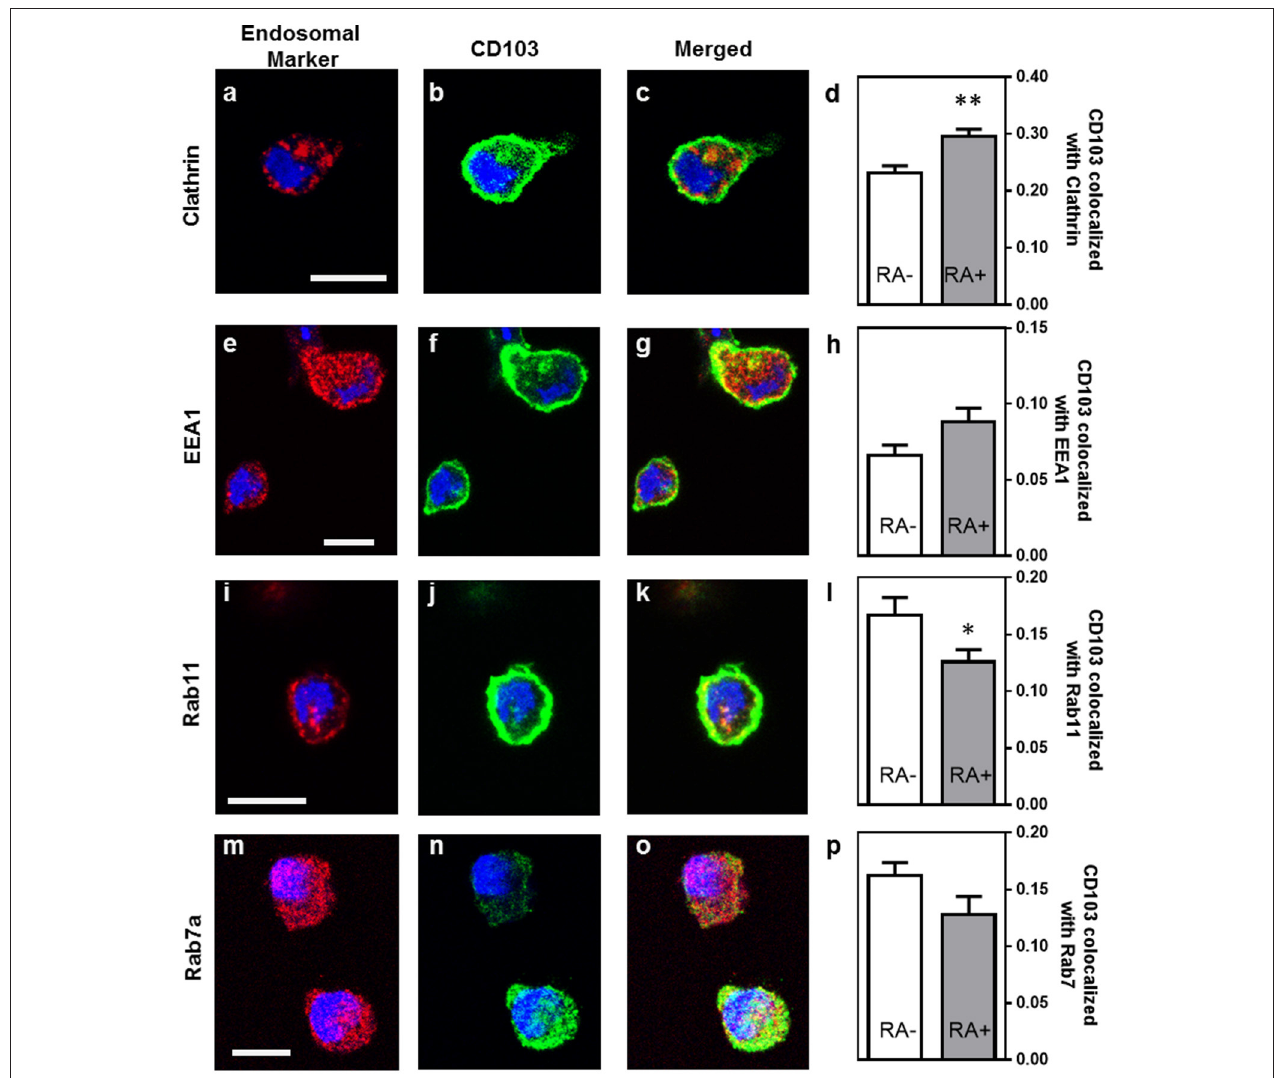
FIGURE 4 | Partial co-localization of CD103 with endosomal markers in human MoDCs. MoDCs generated in medium alone or in the presence of retinoic acid (RA, 100nM) were permeabilized and stained with antibodies to CD103 (green) and the following endosomal markers (red): (a–c) clathrin, (e–g) EEA-1, (i–k) Rab11, and (m–o) Rab7a. Images were obtained by confocal microscopy. Co-localization of CD103 with (d) clathrin, (h) EEA-1, (l) Rab11, and (p) Rab7a was calculated as the Manders’ colocalization coefficient (M2) using ImageJ. Mean ± SEM of 10 − 17 confocal images obtained from two independent experiments. Bar = 20 µ m, * P ≤ 0.05; ** P ≤ 0.01; unpaired Student’s T